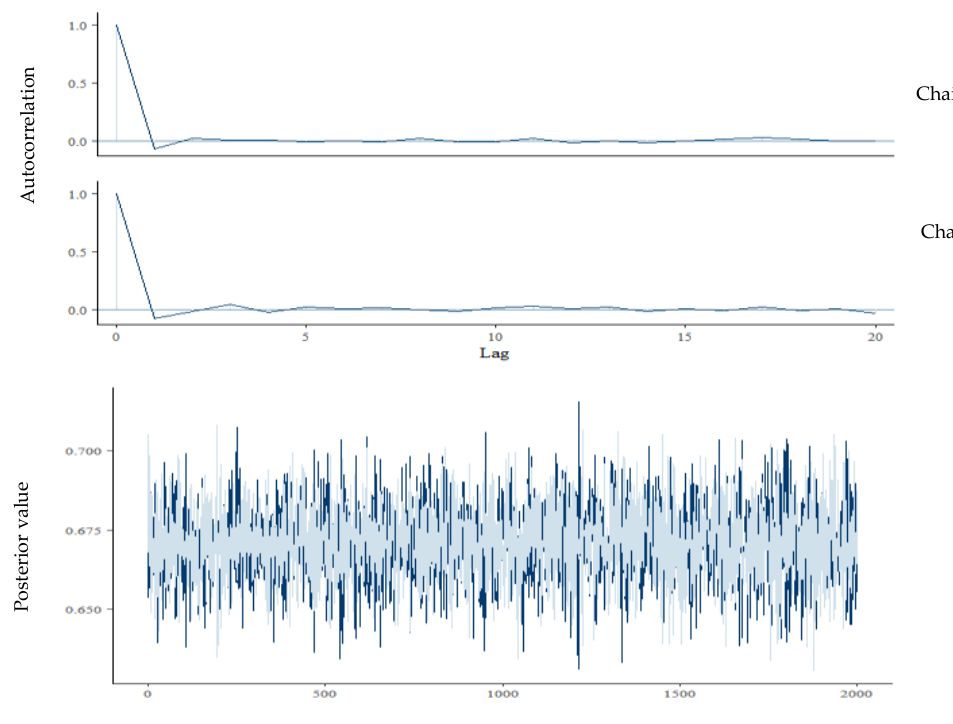
Figure 3. Autocorrelation and trace plots for the coefficient of the variable household size. Chain 1 and chain 2 are the 2 Markov chains used in our MCMC techniques for all estimations.